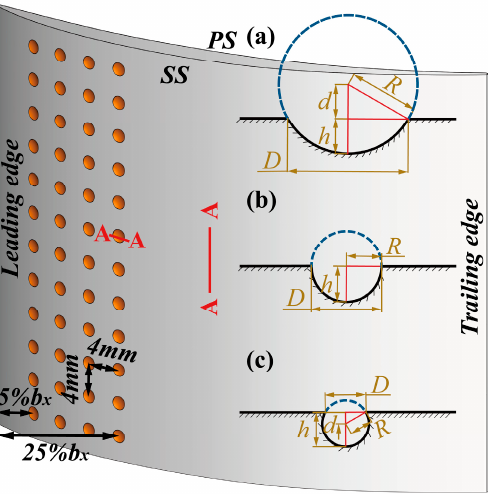
Figure 1. Schematic of cascade.